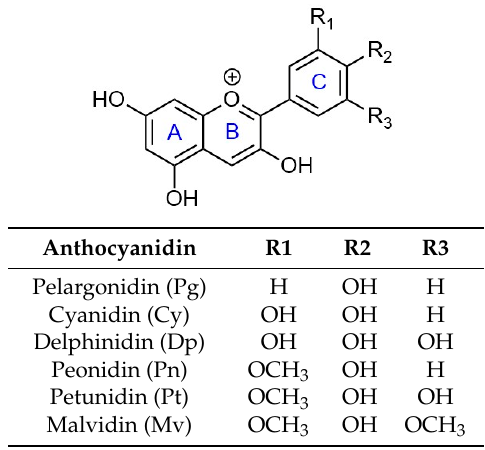
Figure 3. Flavylium ion structure and chemical groups of the anthocyanidins present in red fruits.